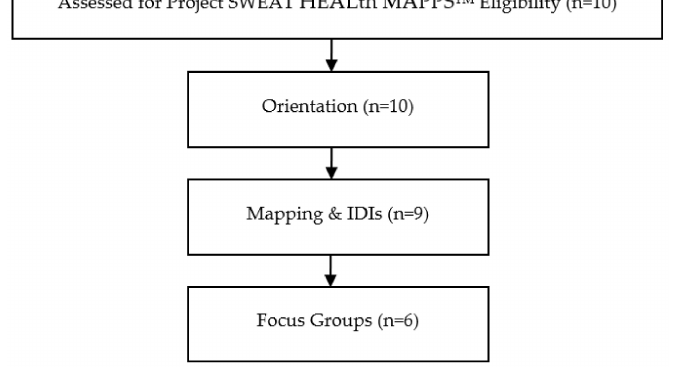
Figure 2. Project SWEAT HEALth MAPPS TM CONSORT flow